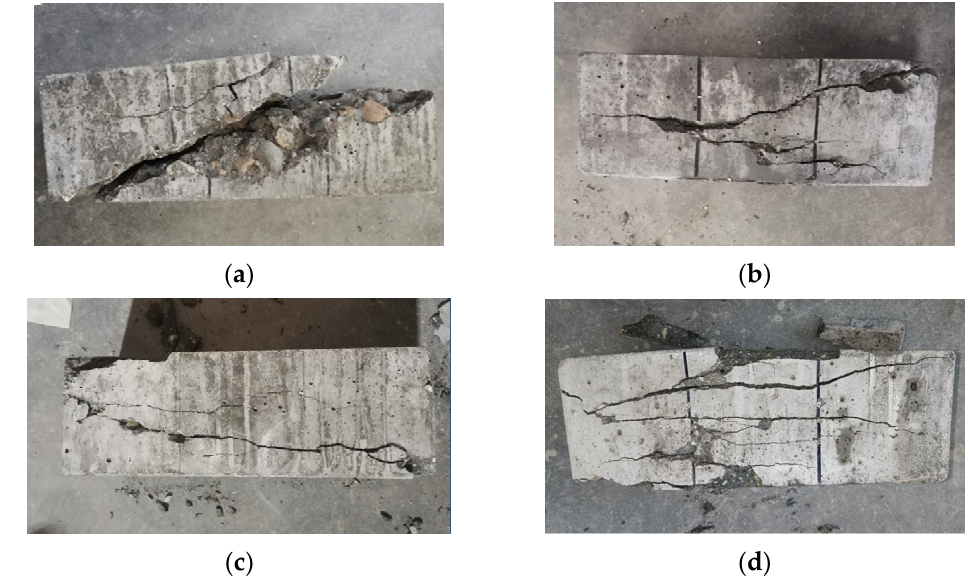
Figure 11. Relations between f cuT / f cT and concrete age.